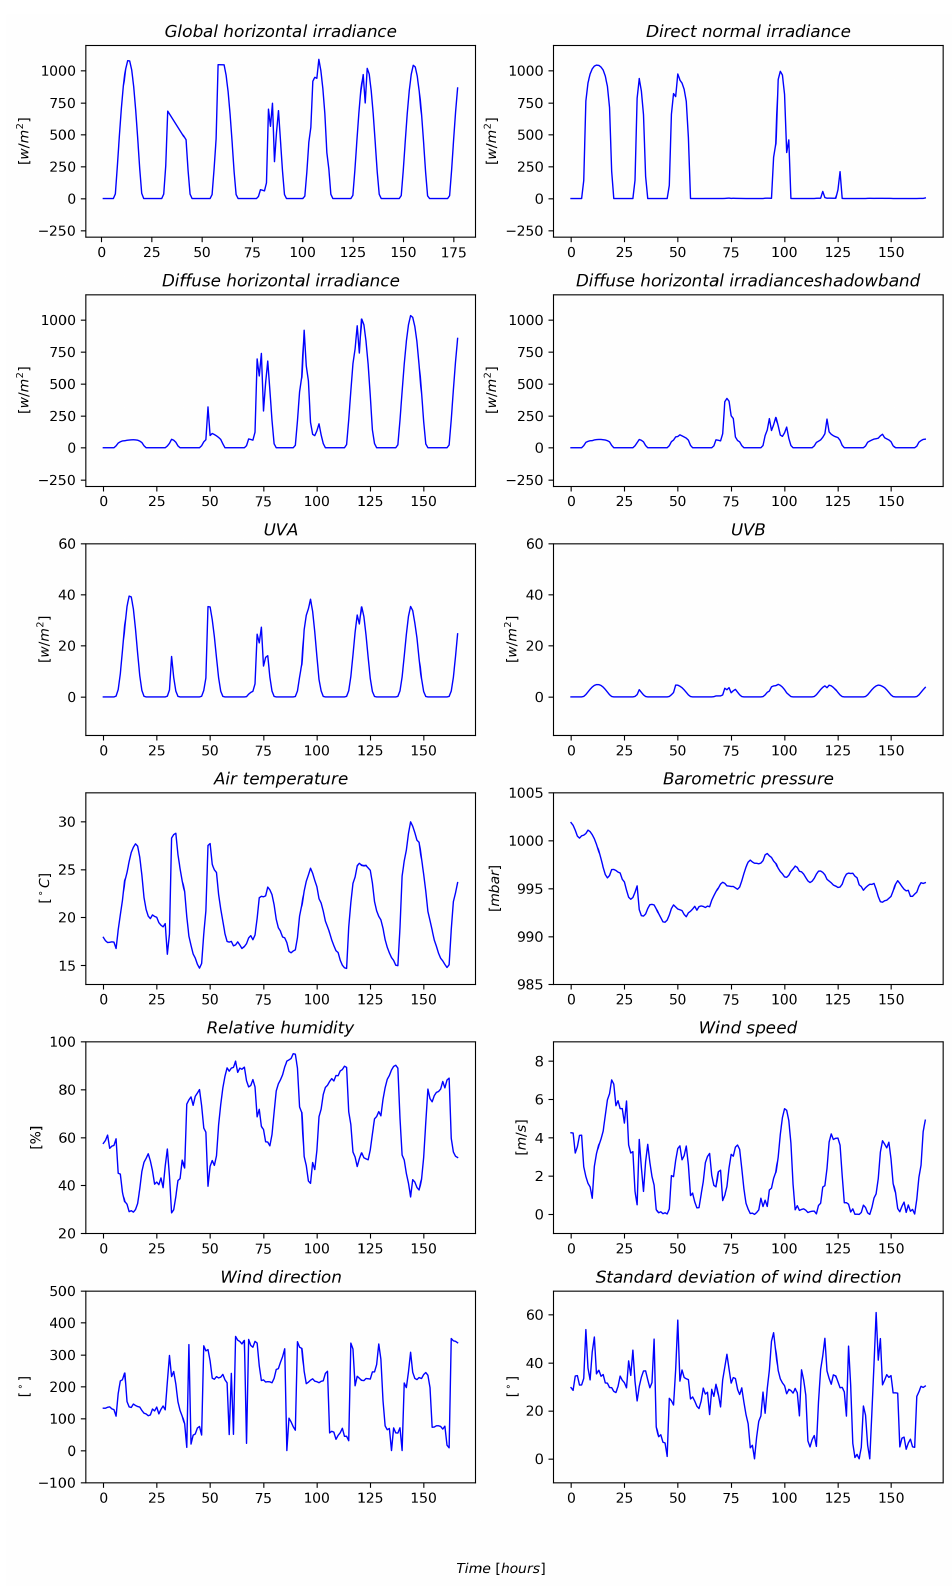
Figure 6. Plots of the weather metrics obtained from the Stellenbosch University weather station of the South African Universities Radiometric Network, for the week 1 February 2015 to 8 February